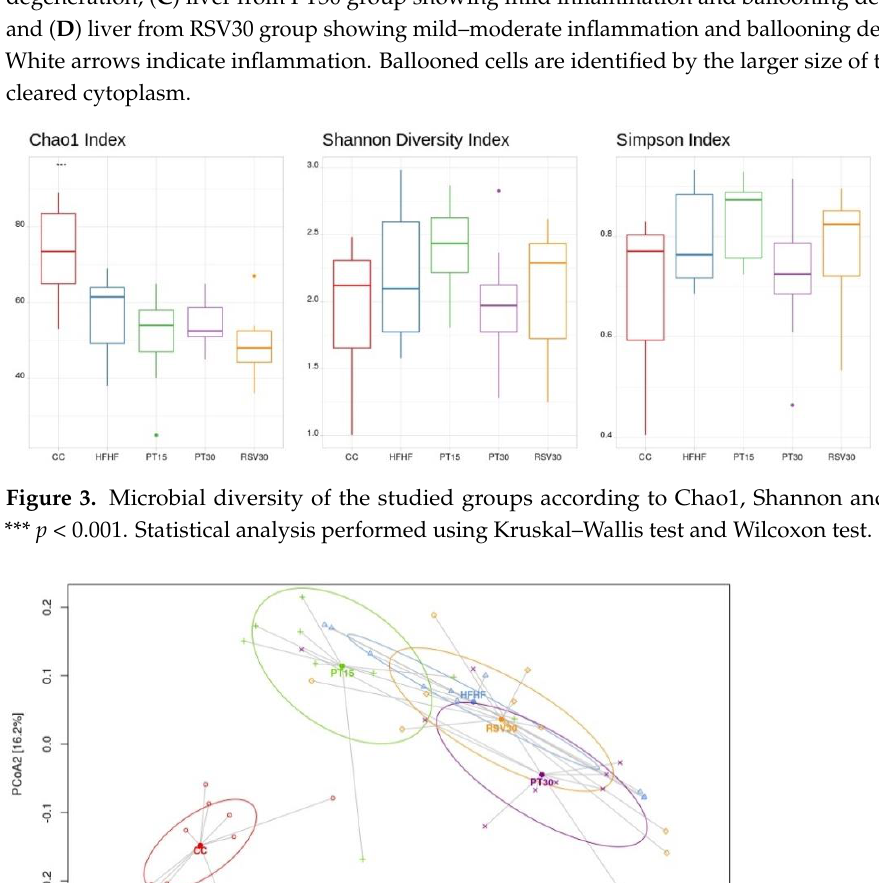
Figure 3. Microbial diversity of the studied groups according to Chao1, Shannon and Simpson. *** p < 0.001. Statistical analysis performed using Kruskal–Wallis test and Wilcoxon test. Figure 4. PCoA plot Weighted Unifrac plot. Components PCoA1 and PCoA2 are shown. All samples are connected to the centroid (shown as a point) of the treatment or control group to which they belong.